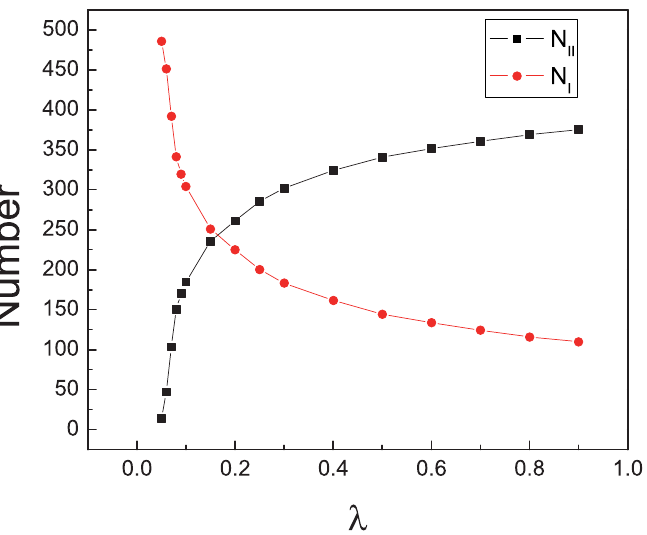
Fig 10. The statistics of the escaped pedestrians. N I and N II are the number of pedestrians with motion mode I and mode II when pedestrians get out of the room. All the data points above are obtained by averaging over 500 different realizations. Initially, N II =